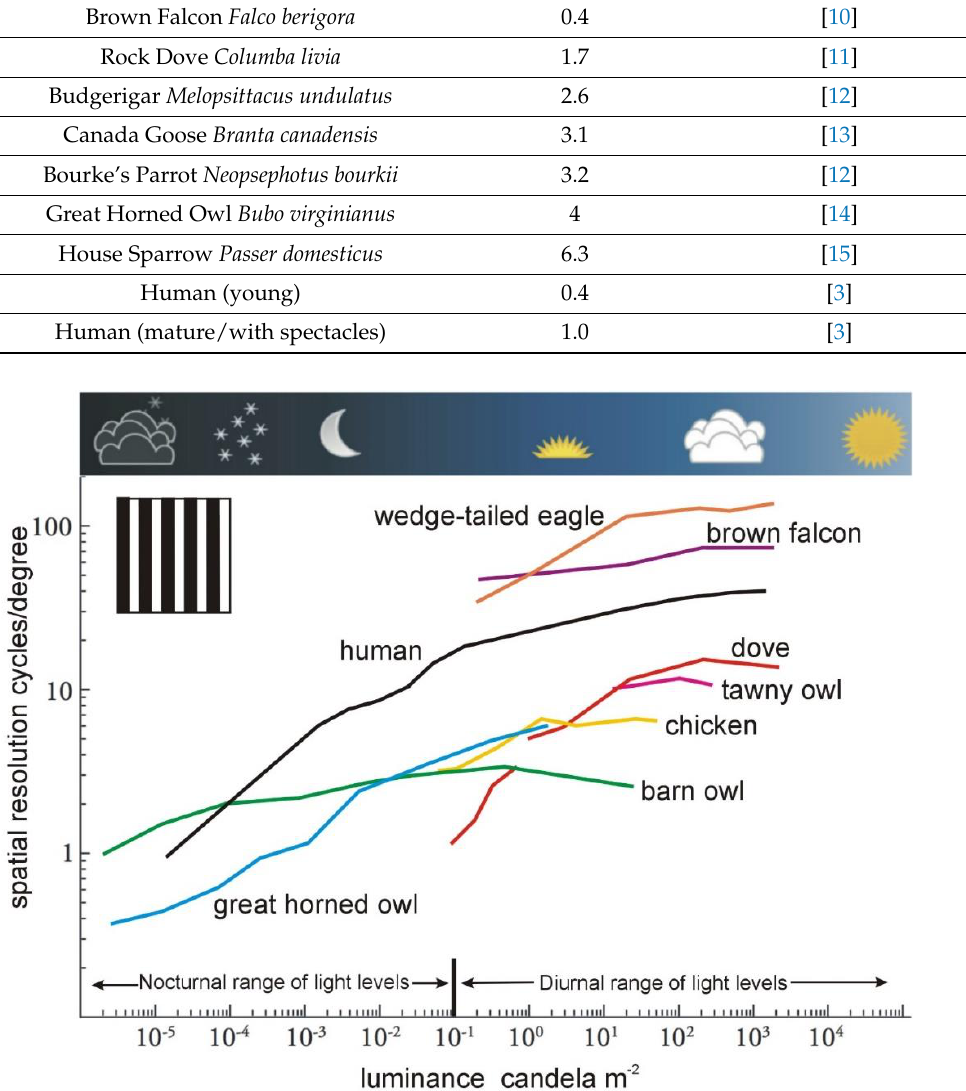
Figure 1. Resolution and light levels. The effect of light levels on visual resolution is significant. Acuity is often measured or estimated at high daytime light levels, but in a few bird species acuity has been measured across almost the full range of naturally occurring light levels. In some species, acuity has been determined across the narrower range of the light levels that occur in daytime and in some species across the daylight-twilight range. This figure shows some key points about the effect of light levels on spatial resolution. In all species shown here acuity has been determined using behavioural training techniques. Although the maximum acuities of these different species are significantly different (for example, the maximum acuity of the eagle is 60 times higher than that of the dove) it is also clear that in all species acuity decreases considerably as natural light levels fall. The only species in which there is not a steep decline in acuity are Western Barn Owls Tyto alba , but even in Barn Owls acuity shows a significant fall as light levels decrease to the lower ranges of